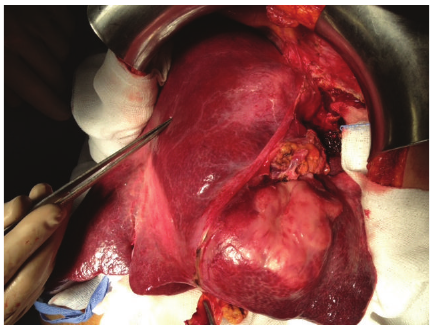
Figure 2: Intraoperative view of the lesion.